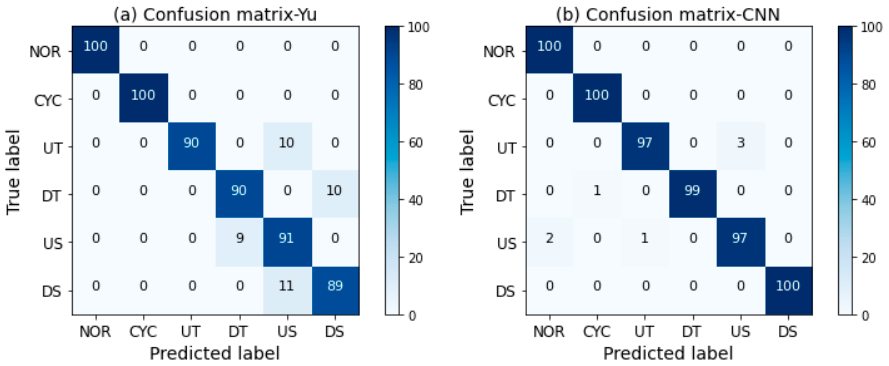
Figure 15. Confusion matrices for the worst case in ten runs of experiment 2. For ease of comparison, the metrices were not normalized.